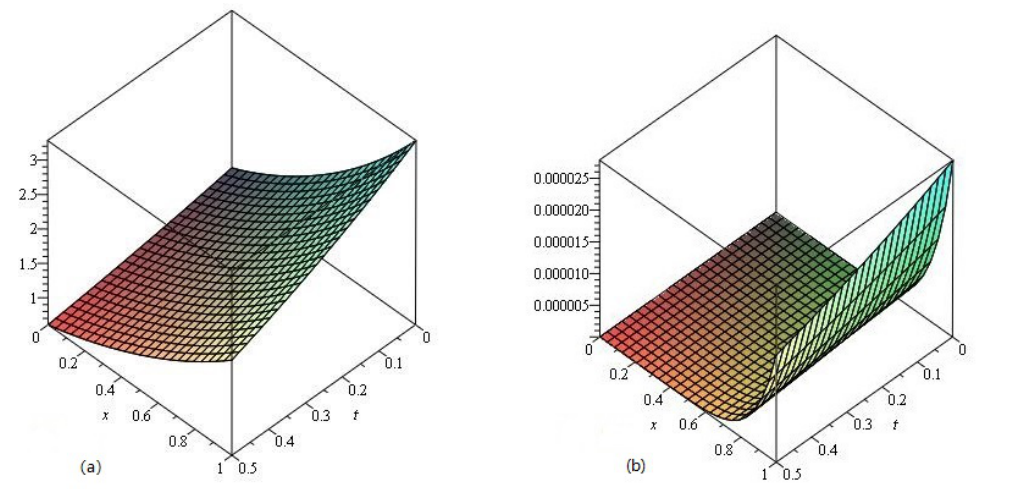
Figure 5. The LADM solution of υ ( x , t ) of Example 2 at ( a ) γ = 0.50 and ( b ) Error plot at γ =